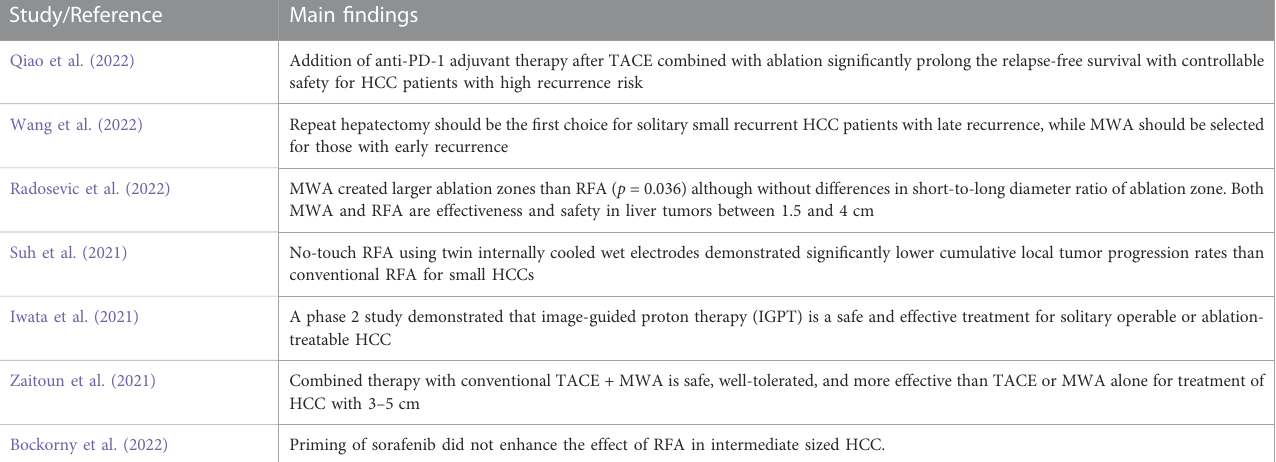
TABLE 2 Main fi ndings of the recent clinical trials in the fi eld of HCC ablation.